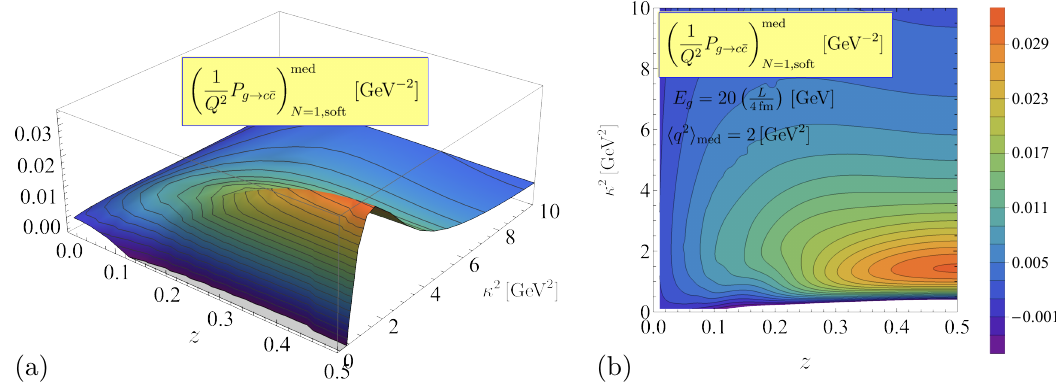
Figure 12 . The medium-modification (3.25) of the g → c ¯ c splitting in the N = 1 opacity expansion for ‘soft’ Gaussian-type scattering centres (D.3), plotted as a function of z and final transverse momentum (cid:20) 2 . A similar figure for Yukawa-type scatterings was shown in figure 3.